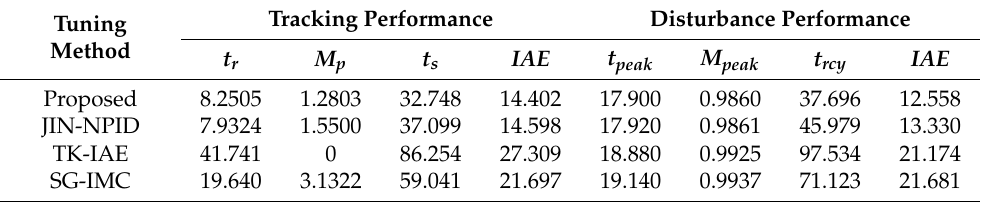
Table 11. Quantitative comparison of performances for nominal process